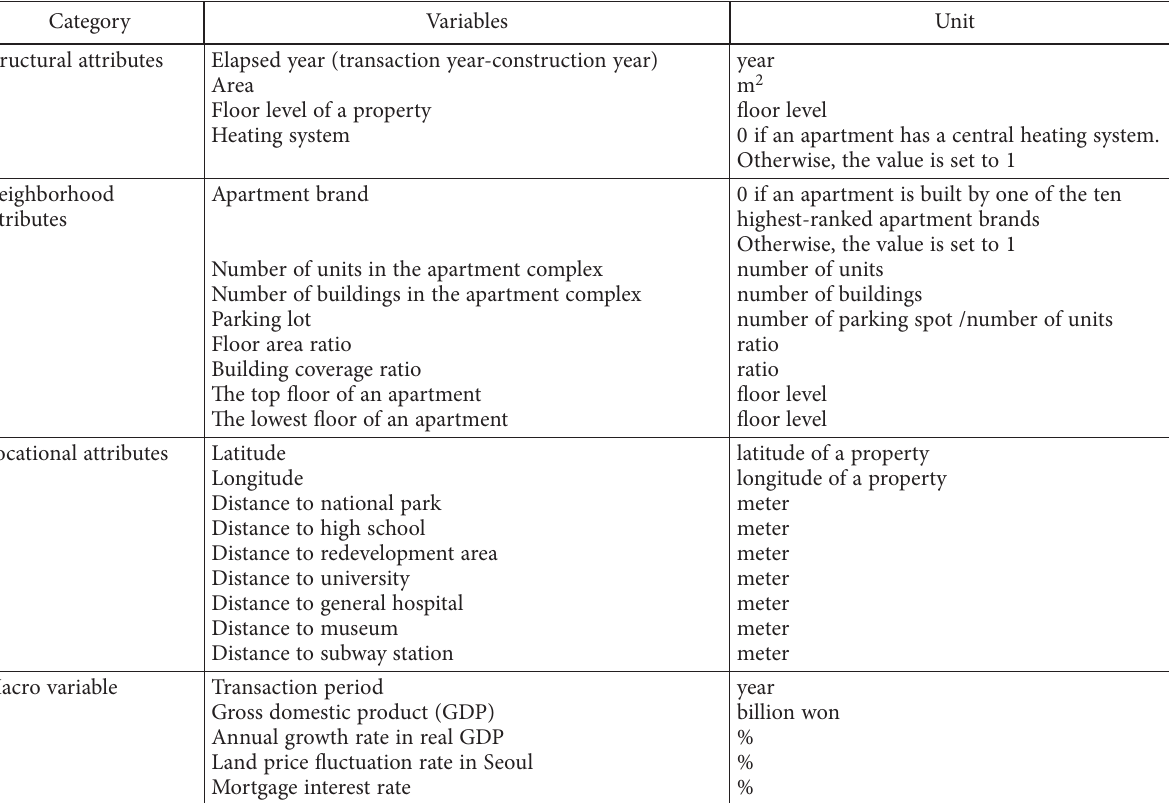
Table 1. Variables used for forecasting house